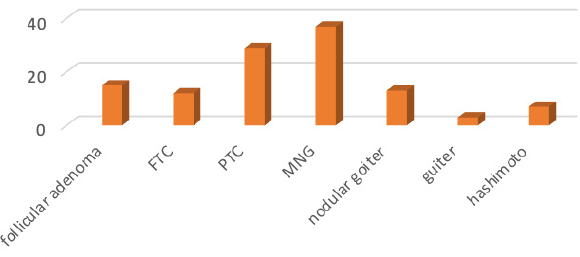
Figure 2: Frequency comparison of pathologic results of thyroid nodules.